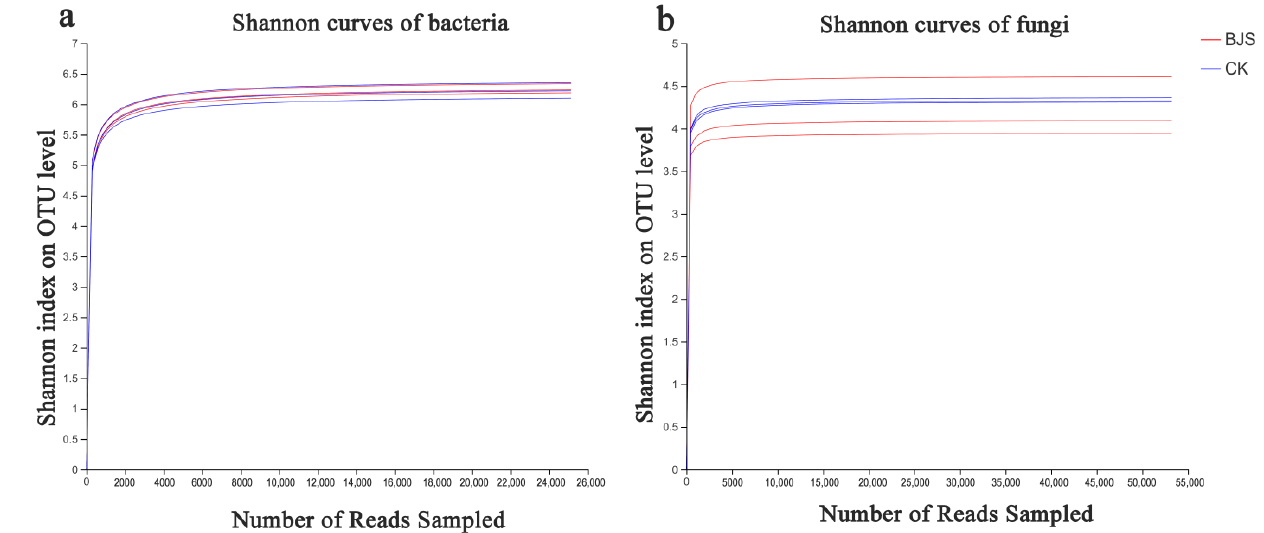
Figure 2. A Shannon curve of bacterial communities ( a ) and Shannon curves of fungal communities ( b ). Shannon curves illustrate the effects of a 3% dissimilarity cutoff on uncovered OTUs. “BJS-1-3” means BJS-1-3 fermentation-broth-treated poplar group; “CK” means sterilized fermentation-broth- treated poplar group. For each treatment, three replicates were